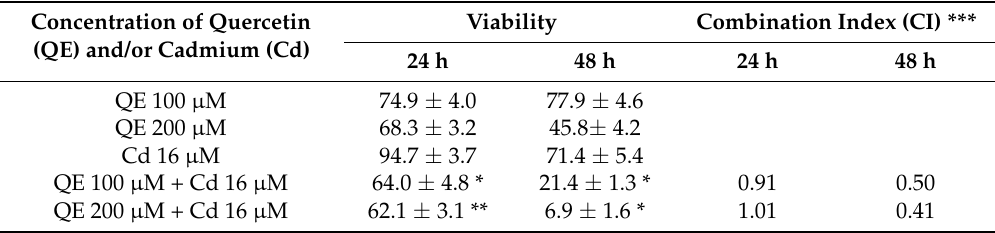
Table 2. Evaluation of the QE and Cd combined effect on the viability of 132N1 astrocytoma cells in vitro. Concentration of Quercetin (QE) and/or Cadmium